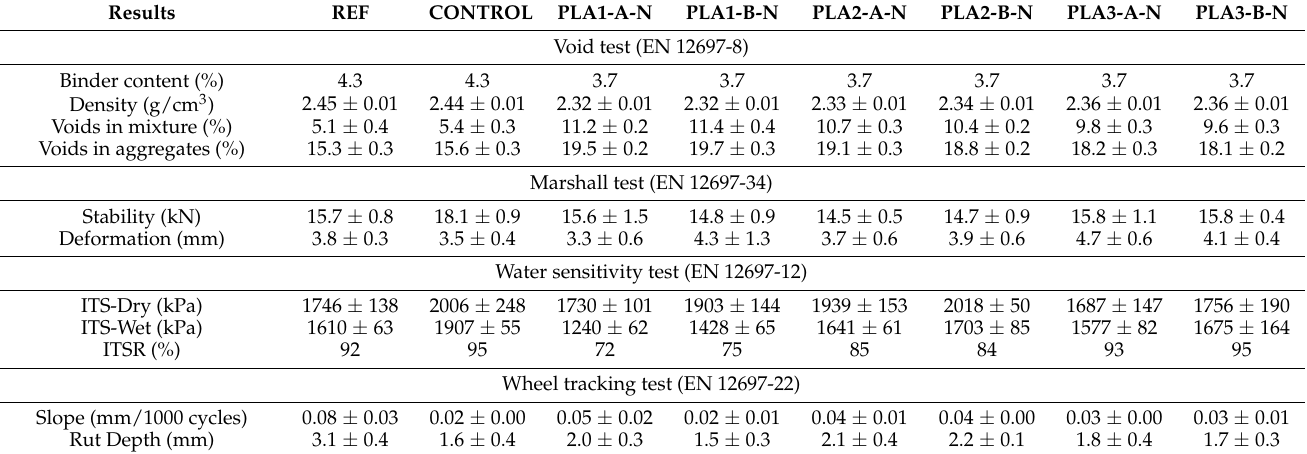
Table 4. Mechanical performance. Analysis of the plastic addition process and type of